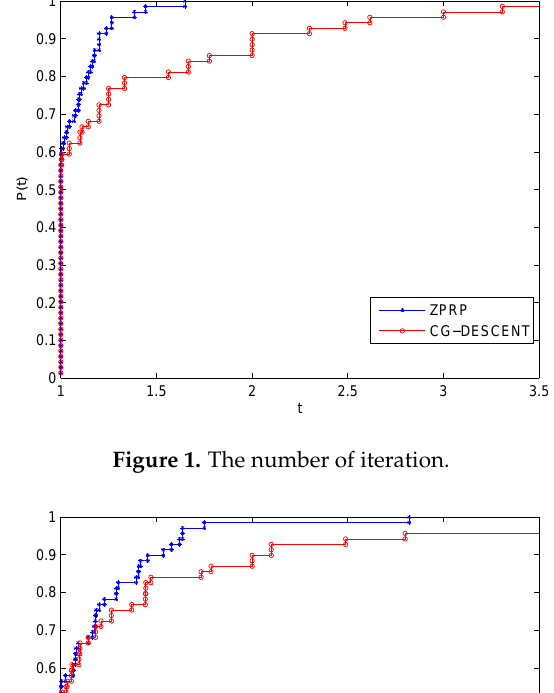
Figure 2. The total number of function and gradient